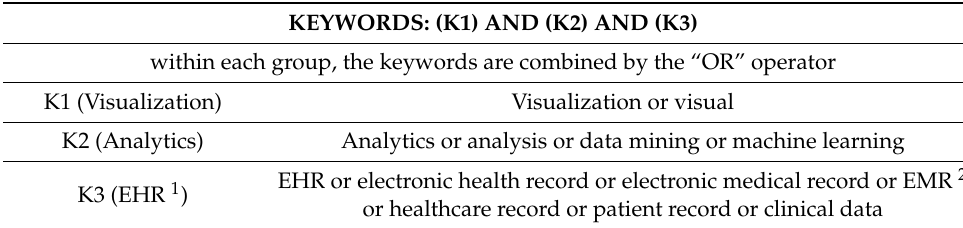
Table 1. Search terms used to identify studies related to EHR-based VA. KEYWORDS: (K1) AND (K2) AND